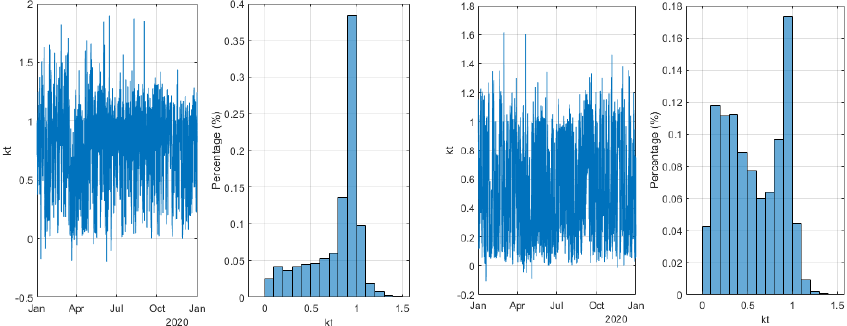
Figure 7. The kt profiles and histograms for V29 and C01.